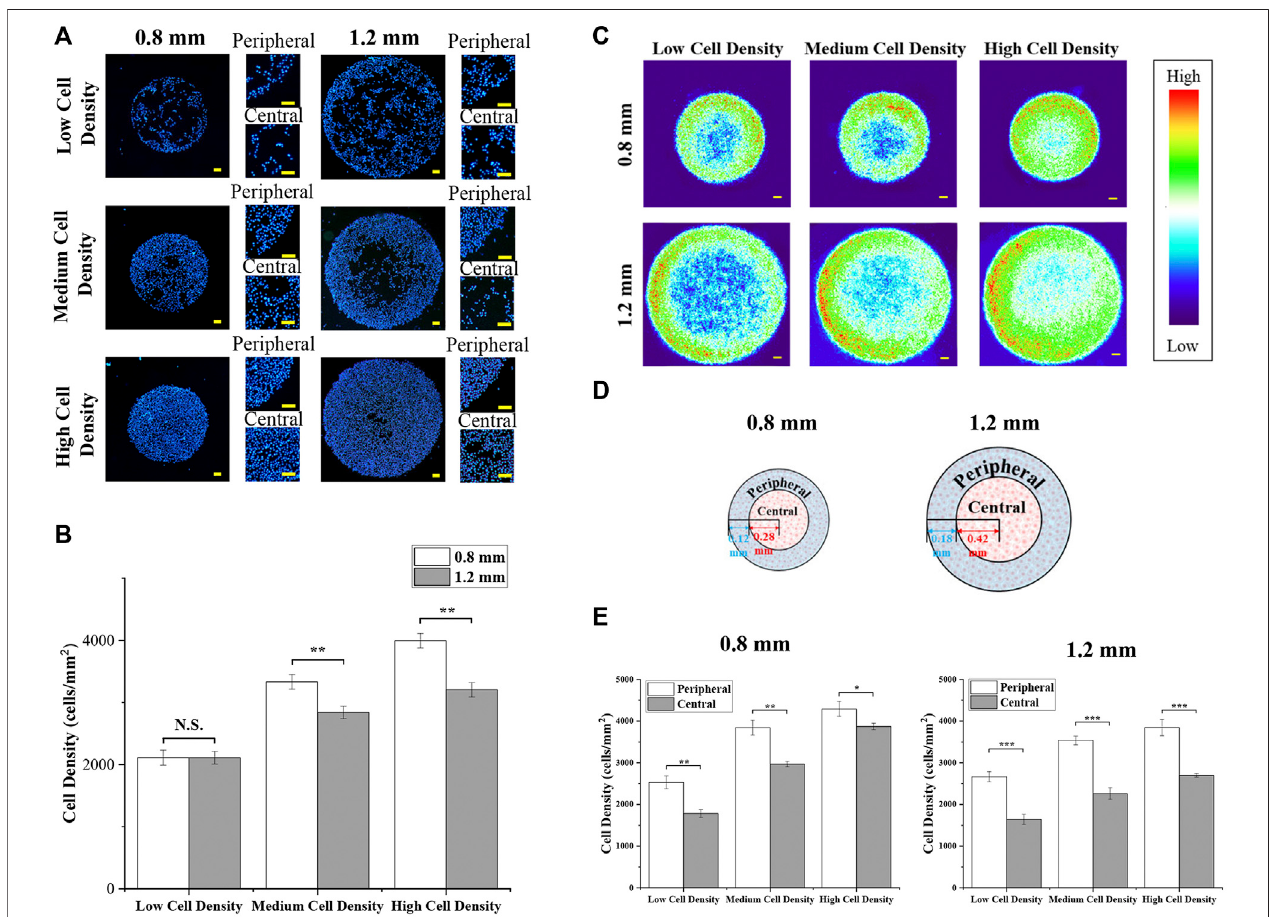
FIGURE 2 | Cell distribution of micropatterned colonies. (A) Distribution of DAPI-stained nuclei in colonies with different diameters and cell densities. Scale bar: 50 μ m. (B) Cell density of micropatterned colonies. (C) Heat maps of DAPI-stained nuclei. Scale bar: 50 μ m. (D) Illustration of the peripheral region and central region in micropatterned colonies. (E) Cell density of the de fi ned peripheral and central regions in micropatterned colonies with different diameters and cell densities. Data are presented as means ± SDs ( n = 5). * p < 0.05, ** p < 0.01, *** p < 0.001.